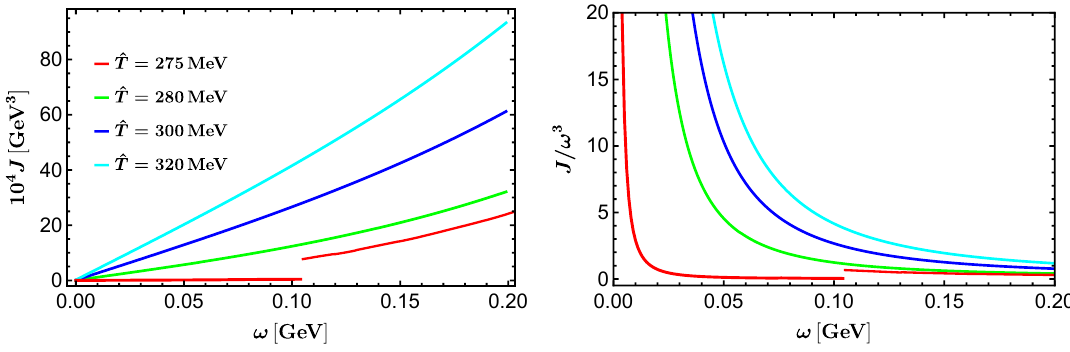
Figure 12 . The angular momentum J (left) and J/ω 3 (right) in function of ω for different temperatures. We have taken ‘ = 1 GeV − 1